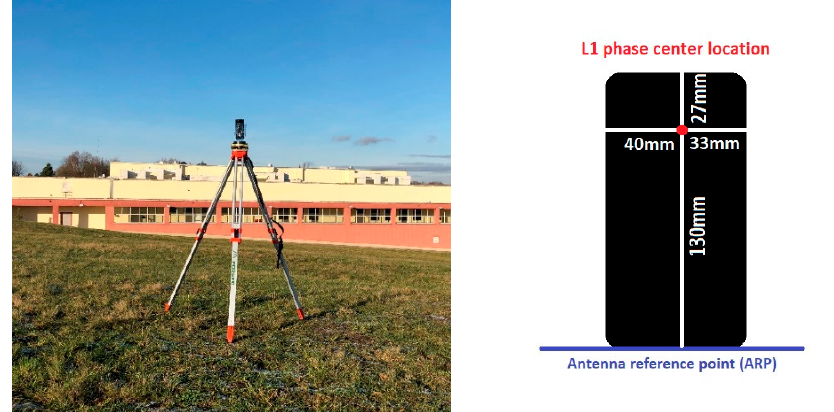
Figure 3. Test area and the initial research on Huawei P30 Pro static positioning accuracy. Huawei P30 Pro L1 phase center location.